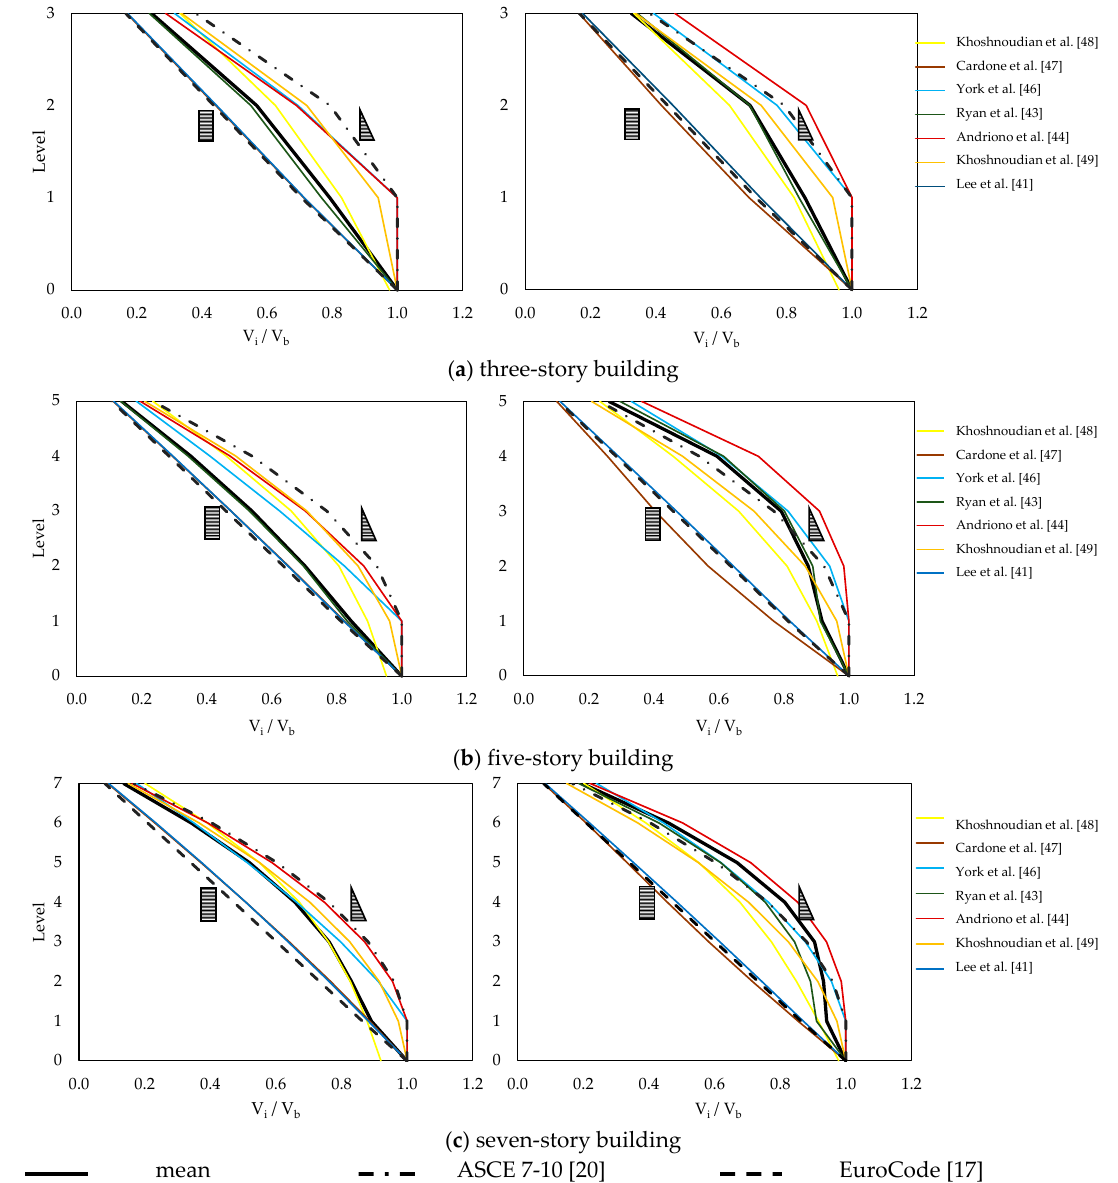
Figure 9. Comparison between the several lateral force distributions available in the literature for the prototype BI buildings of three-story ( a ), five-story ( b ), seven-story ( c ) equipped with different isolation systems.